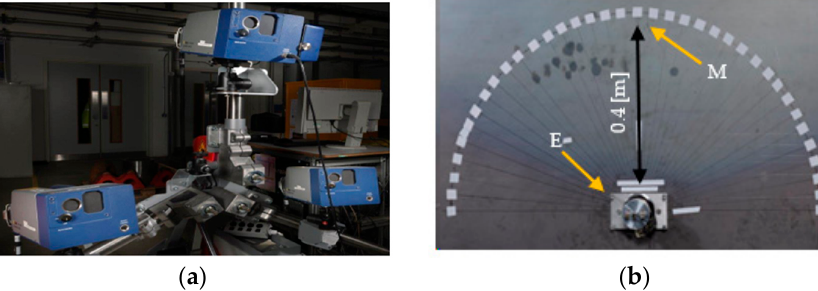
Figure 3. Laboratory experiments to characterize the transducers, 3D Laser Doppler Vibrometer used to monitor the surface vibration at the point of interest ( a ) PSV-400 3D Doppler Vibrometer used to monitor the surface vibration at the point of interest ( b ) experimental setup illustrating the point of excitation (labelled as E) and monitoring point (labelled as M) and the corresponding distance in meters. The mild steel plate chosen for validation was a square plate of dimension 2.0 × 2.0 × 0.003 m.